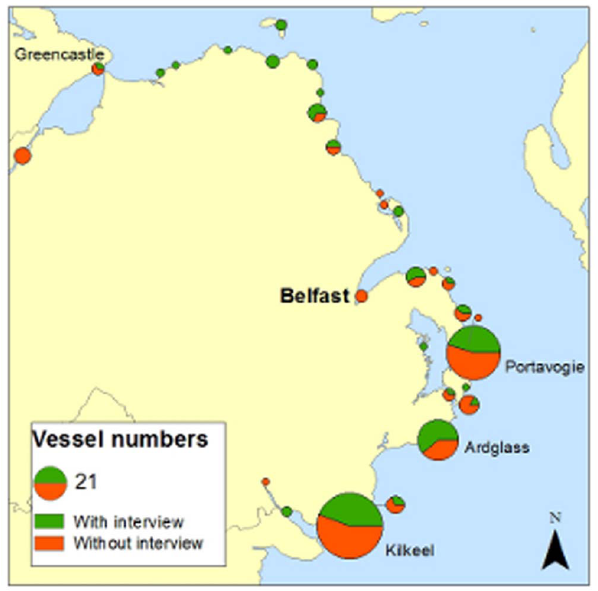
Figure 7. The proportion of vessels for which interviews were obtained or not obtained. Map of the Northern Irish ports, plus Greencastle, showing the proportion of vessels for which interviews were obtain for against those for which they were not. The size of the symbol for each port represents the number of commercially active, Northern Ireland fishing vessels registered there.